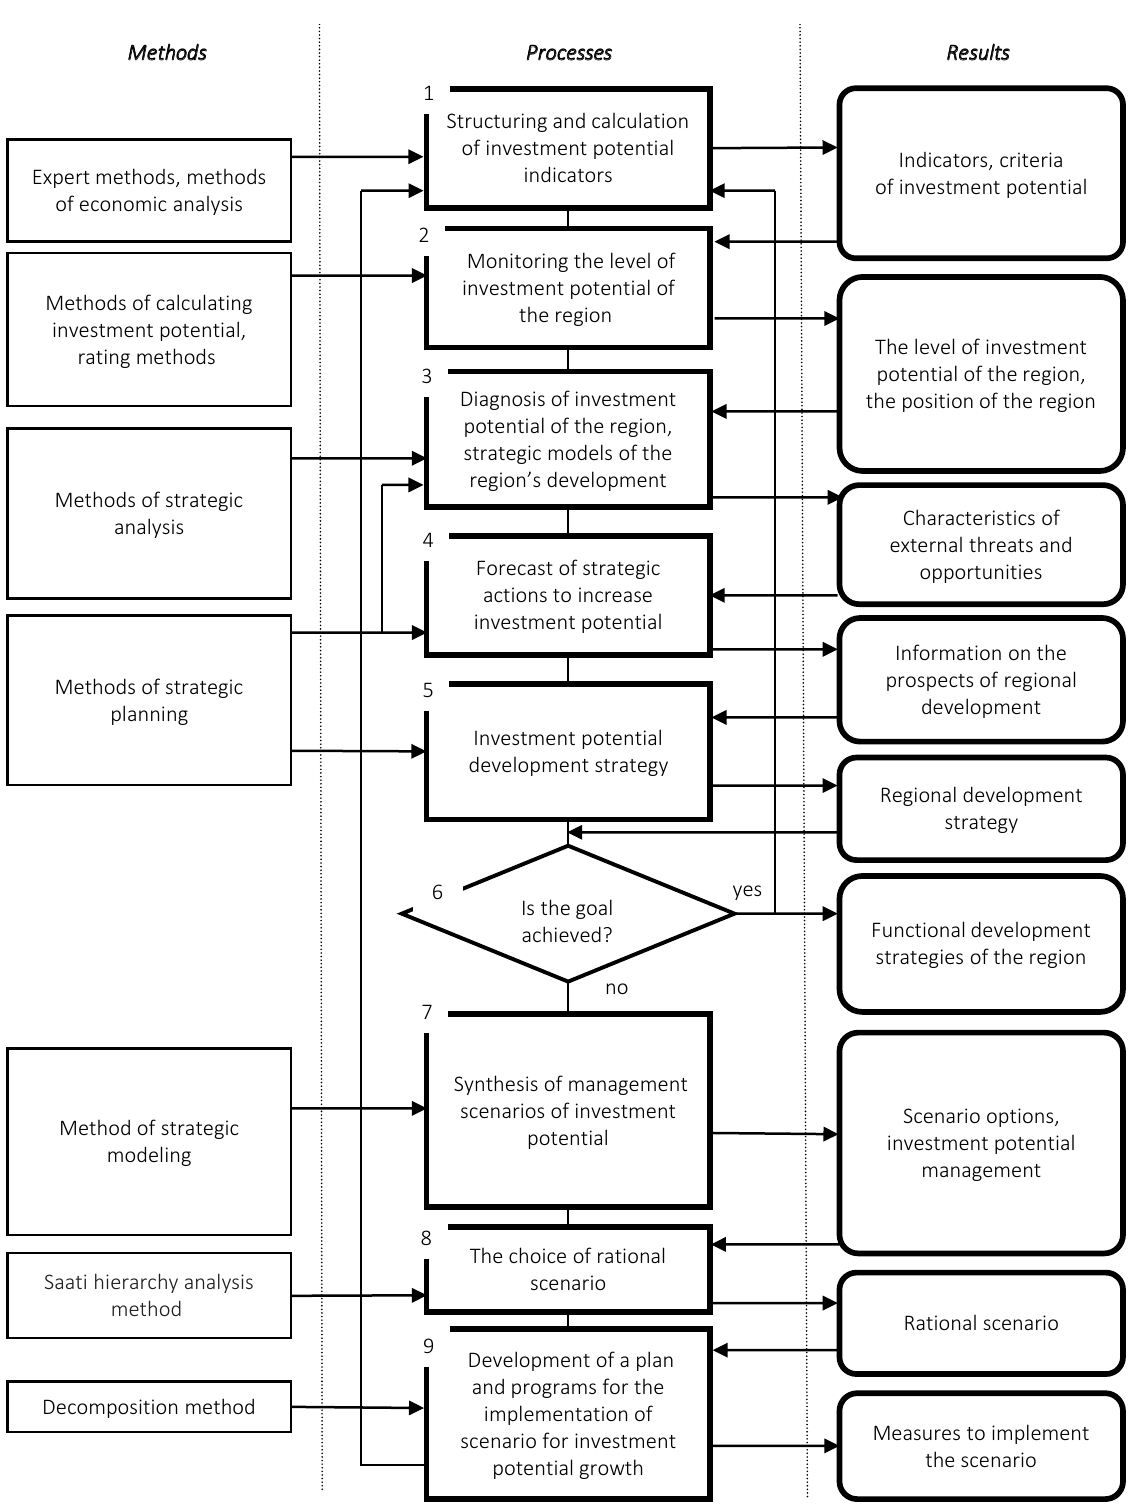
Figure A1. Methods and results of research on the region’s investment